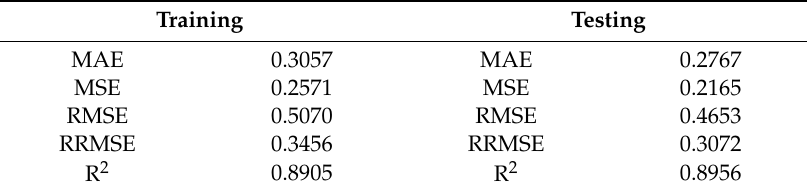
Figure 8. The various effects of variables on MARS models based on the piecewise-linear method. Table 4. Results of slope deformation of earth dam predicted by the MARS model based on the piecewise-linear method.